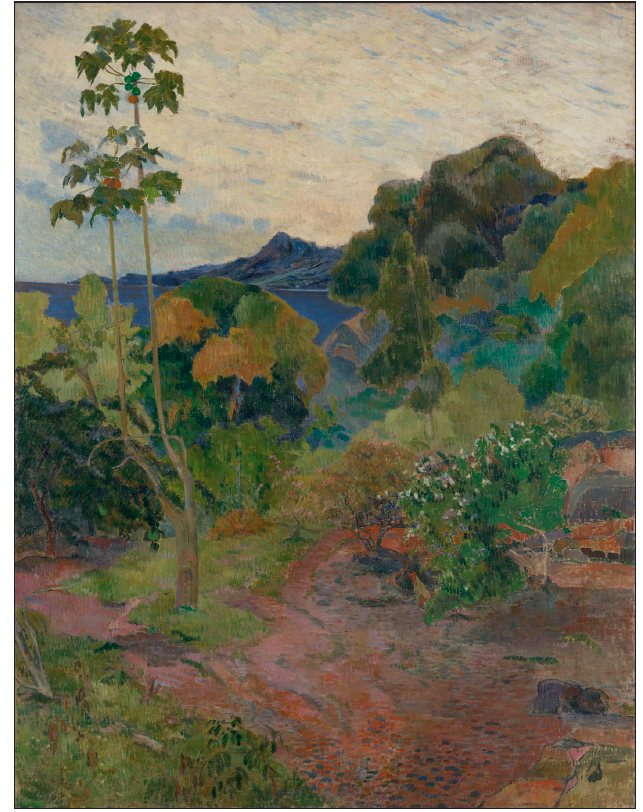
Fig. 6 : Paul Gauguin, Martinique Landscape , 1887, oil on canvas, 117 × 89.8 cm, National Galleries of Scotland, Edinburgh. Presented by Sir Alexander Maitland in memory of his wife Rosalind